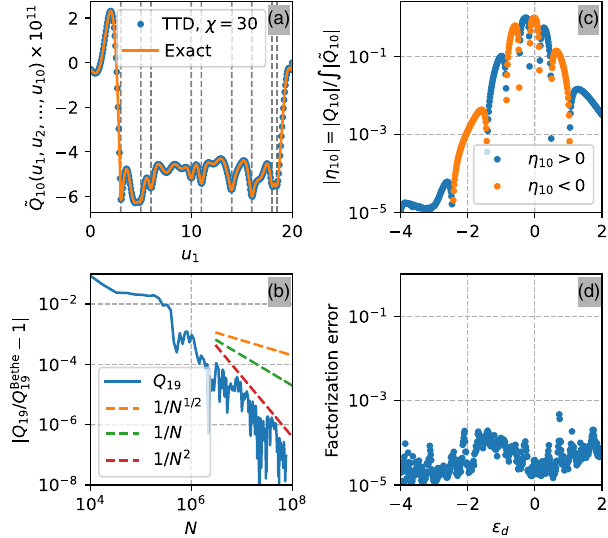
FIG. 1. Overview of the main results. (a) Slice of the corre- ˜ Q 10 (orange line) compared to the MPS sponding integrand approximation (blue dots). The values of u 2 ; u 3 ; … ; u 10 are arbitrarily fixed (vertical dashed lines). (b) Relative error of the n th coefficient (for n ¼ 19 ) in the perturbative expansion of the charge Q of the Anderson quantum impurity model (com- pared with the exact Bethe ansatz solution) versus the number N R ˜ ˜ Q 19 . (c) Average sign defined as η Q = Q of evaluation of j n ¼ n n j for n ¼ 10 versus on-site energy ϵ . (d) Relative error of the rank- d 50 MPS approximation [pivot error, as defined in Eq. (24), ˜ Q divided by the value of the function at the first pivot] n versus ϵ d